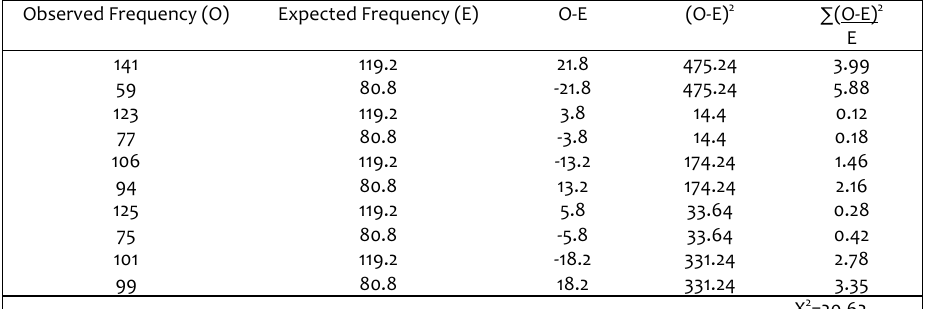
Figure 8: Calculation of chi ‐ square for hypothesis 3